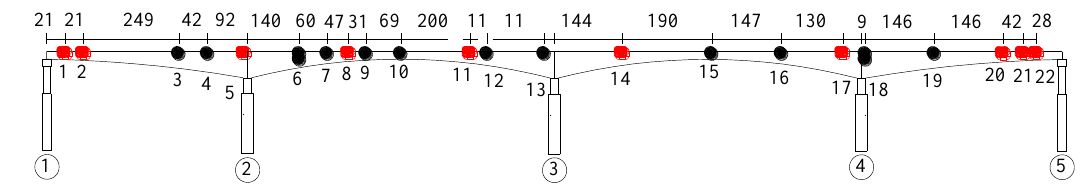
Figure 6. Sensor deployment on the bridge girder.